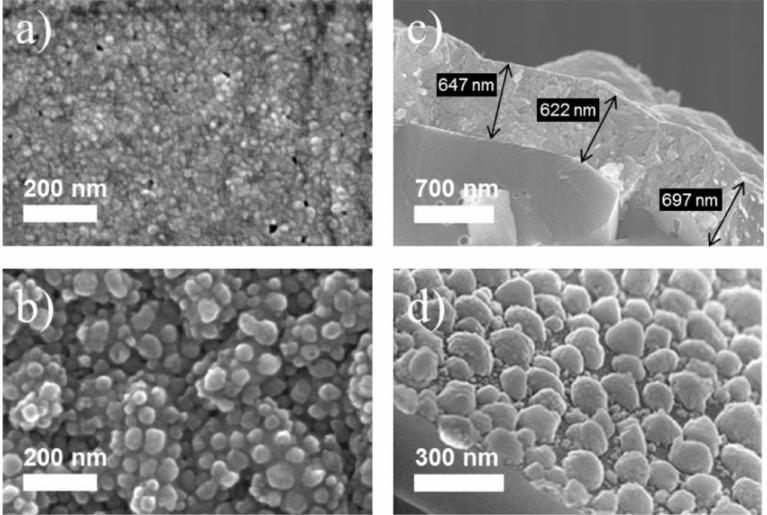
Figure 1. Surface morphologies of a flat-surface ( a , c ) and of a granular surface morphology film ( b , d ). Images ( a ) and ( b ) present top surface scanning electron microscopy (SEM) pictures of both kinds of films; images ( c ) and ( d ) display similar films after cleaving their substrates and after performing oblique-angle SEM on the cleaving